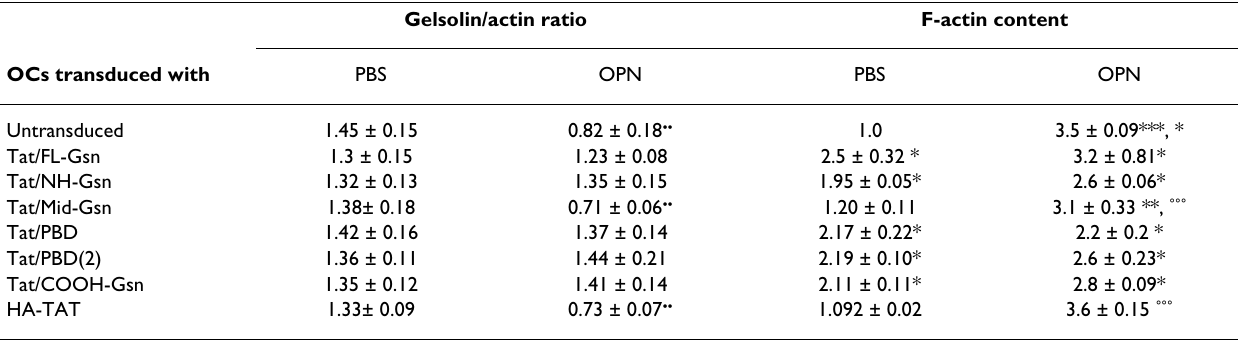
Table 1: The effects of HA-TAT-protein transductions and OPN treatment on gelsolin/actin ratio and F-actin content of osteoclasts. F- actin content was measured by rhodamine-phalloidin binding in osteoclasts treated as indicated in the table. About 4–5 wells were used for each treatment. The experiment was repeated three times. The data presented are mean ± SE for three